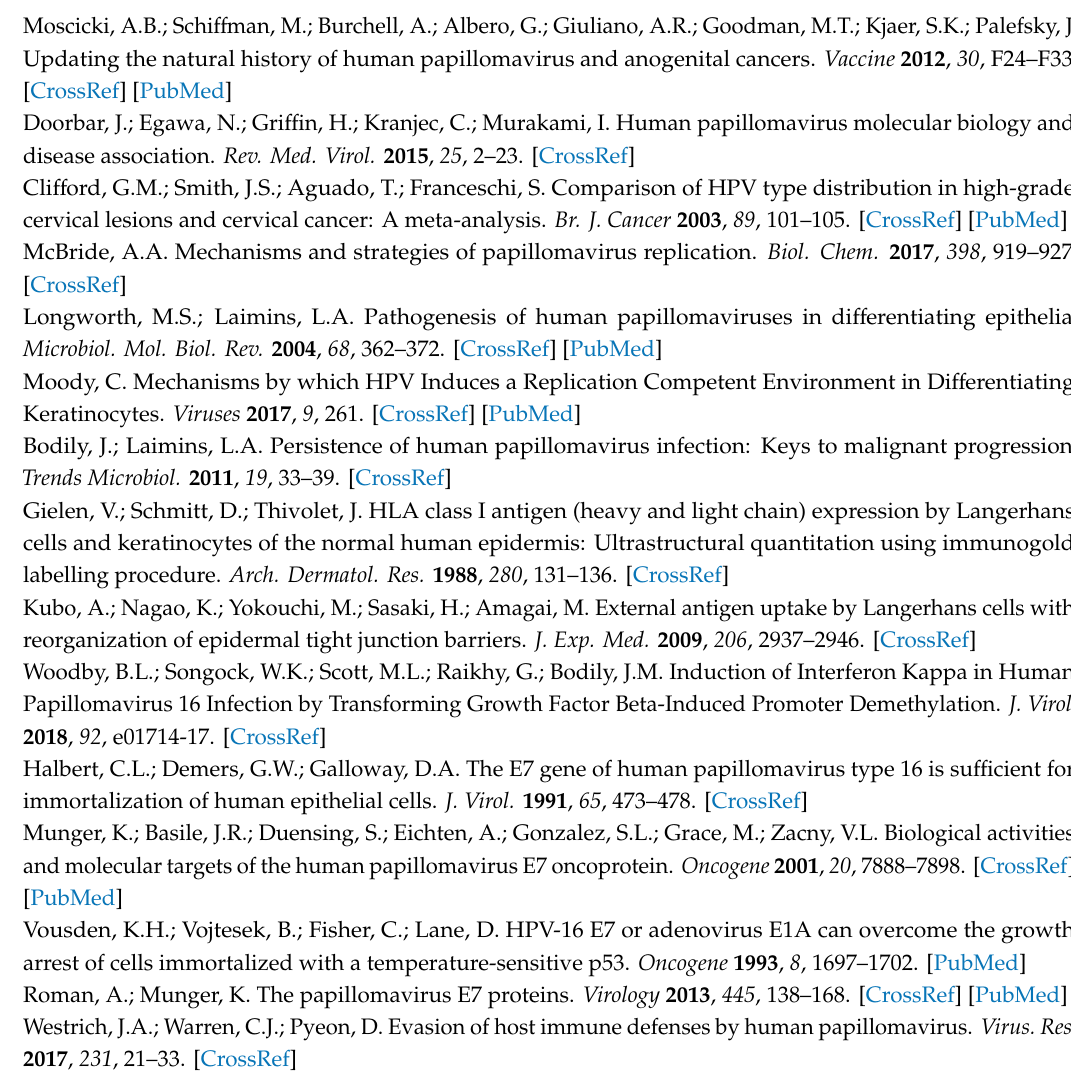
Figure S1: Growth rate and integration of CR3 mutants, Figure S2: E ff ect of Ruxolitinib on ISG levels, Figure S3: E ff ect of CDK8 knockdown on ISG expression, Figure S4: E ff ect of CDK8 kinase inhibition on ISG expression, Table S1: Oligos used in this study, File S1: Unfiltered RNA-sequencing results of genes di ff erentially expressed in pLXSN E6 / E7 F57A cells, as compared to pLXSN E6 / E7 cells, File S2: Reactome analysis of RNA-sequencing results of genes di ff erentially expressed in pLXSN E6 / E7 F57A cells, as compared to pLXSN E6 / E7